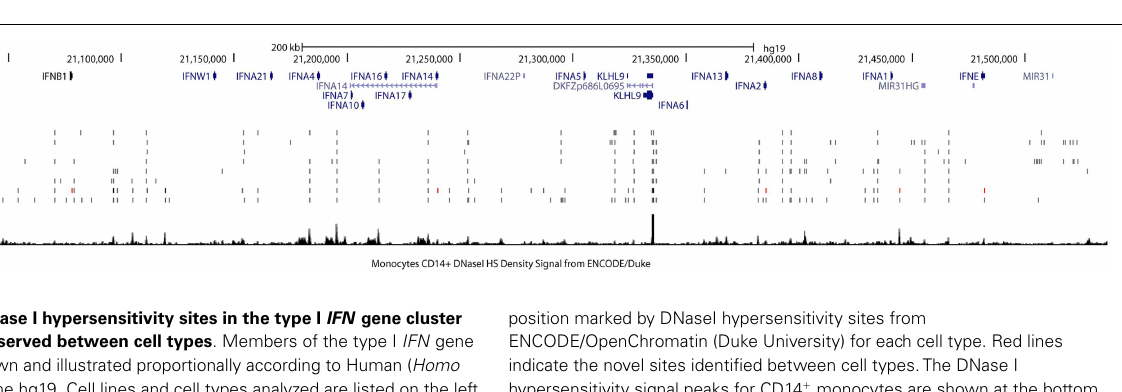
FIGURE 2 | DNase I hypersensitivity sites in the type I IFN gene cluster are highly conserved between cell types . Members of the type I IFN gene cluster are shown and illustrated proportionally according to Human ( Homo sapiens ) genome hg19. Cell lines and cell types analyzed are listed on the left side. Short vertical lines below the gene track indicate the open chromatin